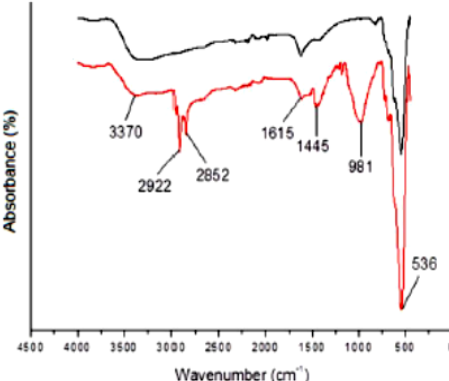
Fig. 2. FT-IR spectra of magnetic nano particles (Black line) and magnetic nano particles modified with n-Octyl (red line)